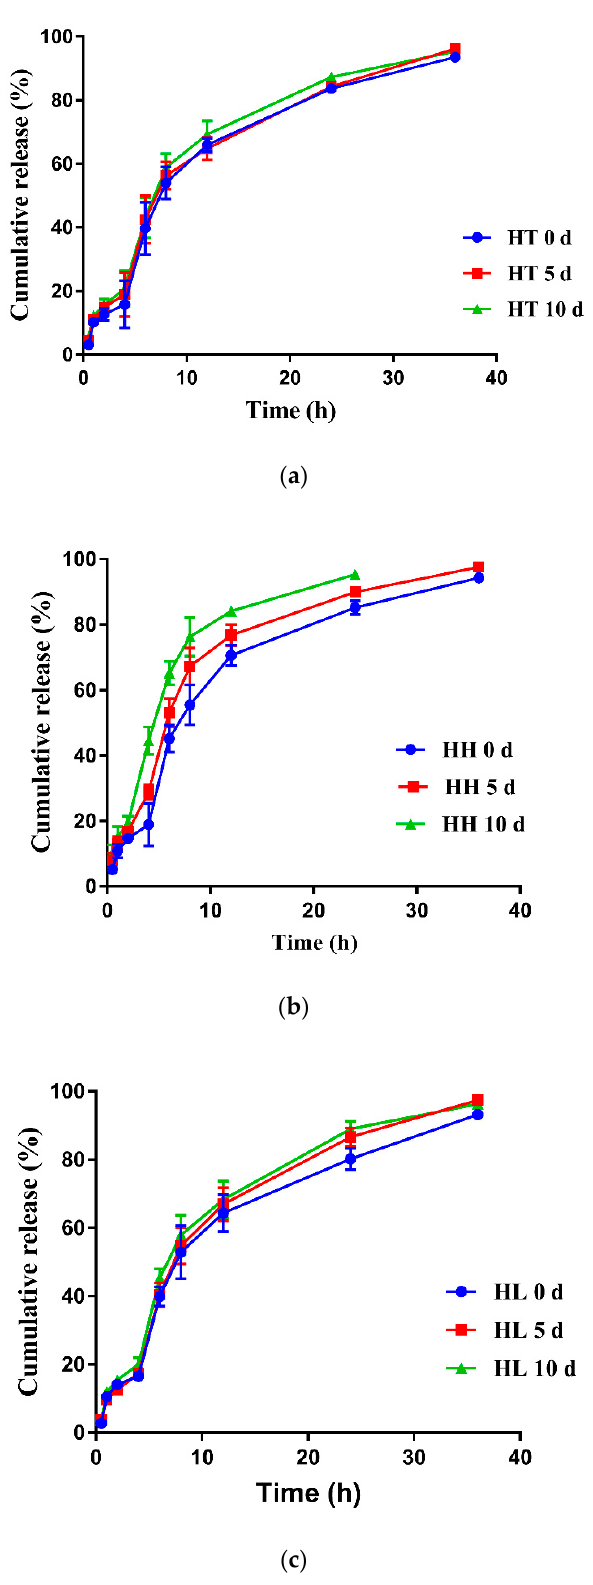
Figure 6. The release profiles of the enteric granules under the influencing factors tests. The release performance of enteric granules showed no obvious change under the influencing factors tests. Note: (a): high temperature; (b): high humidity; (c): high light. HT: high temperature (40 °C); HH: high humidity (25 °C, 90% ± 5%); HL: high light (4500 lux ± 500 lux).